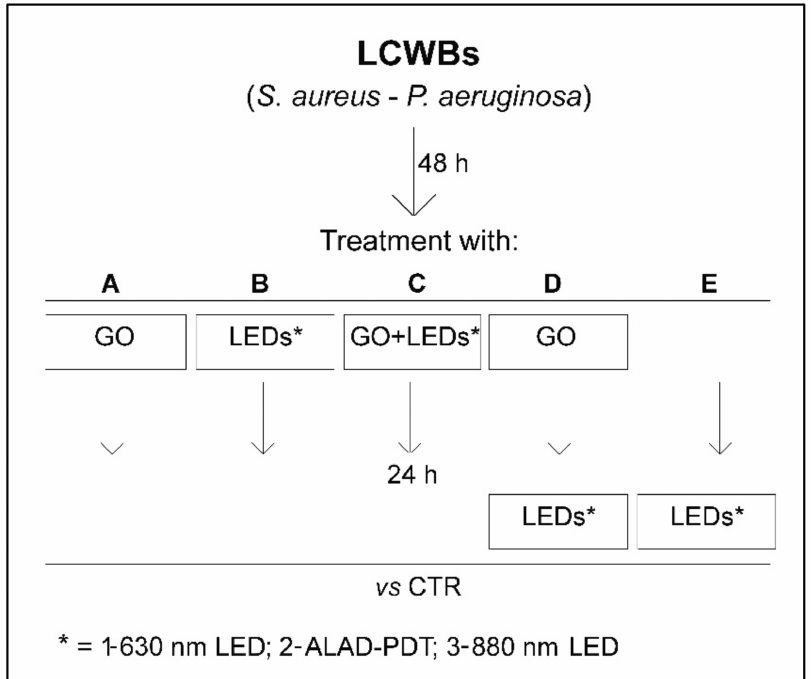
Figure 1. Experimental plan of the study. The mature LCWBs, obtained after 48 h of incubation, were placed on a “wound bed” and treated as follows: A = with GO (50 mg/mL) and incubated for 24 h; B1 = with 630 nm LED for 17 min and incubated for 24 h; B2 = with ALAD-PDT for 17 min and incu- bated for 24 h; B3 = with 880 nm LED for 17 min and incubated for 24 h; C1 = with GO (50 mg/mL) irradiated with 630 nm LED for 17 min and incubated for 24 h; C2 = with GO (50 mg/mL) irra- diated with ALAD-PDT for 17 min and incubated for 24 h; C3 = with GO (50 mg/mL) irradiated with 880 nm LED for 17 min and incubated for 24 h; D1 = with GO (50 mg/mL) incubated for 24 h and then irradiated with 630 nm LED for 17 min; D2 = with GO (50 mg/mL) incubated for 24 h and then irradiated with ALAD-PDT for 17 min; D3 = with GO (50 mg/mL) incubated for 24 h and then irradiated with 880 nm LED for 17 min; E1 = with 630 nm LED for 17 min after 24 h of incubation; E2 = with ALAD-PDT for 17 min after 24 h of incubation; E3 = with 880 nm LED for 17 min after 24 h of incubation. The untreated mature LCWBs (CTRs), after 48 h of incubation, were placed on a “wound bed” and incubated for 24 h in the same time and temperature conditions as all experimental